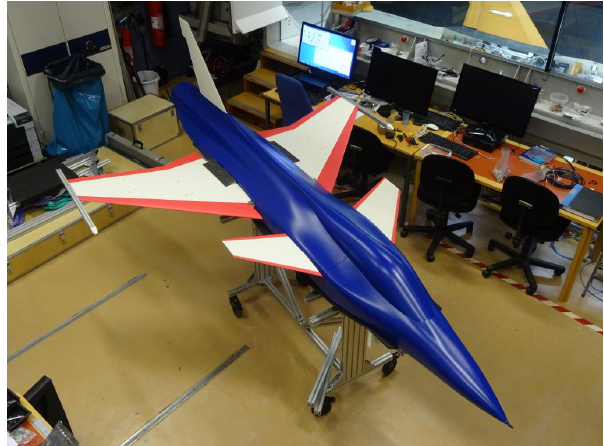
Figure 10. The generic fighter aeroelastic wind-tunnel model tested in summer of 2016.